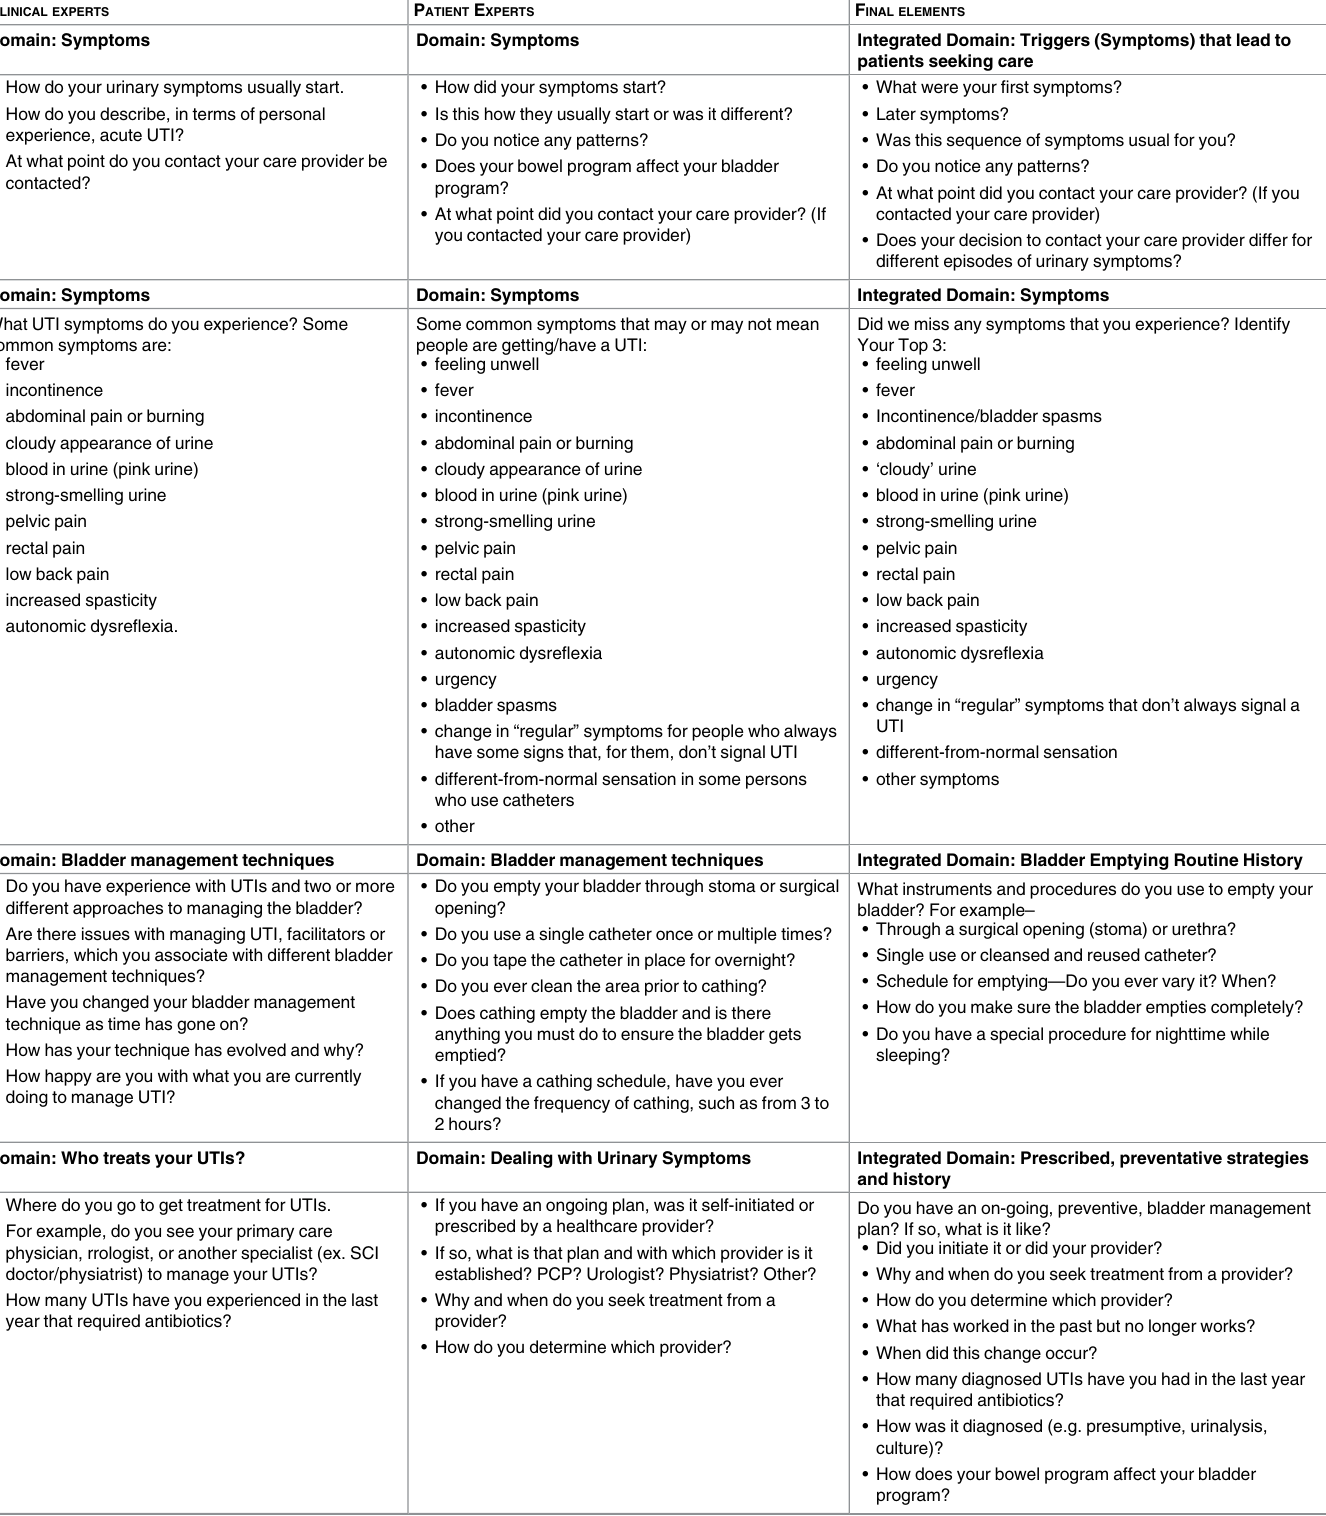
Table 1. Comparison of perspectives of clinical and consumer experts with the final patient focus group script elements, organized by general domains of